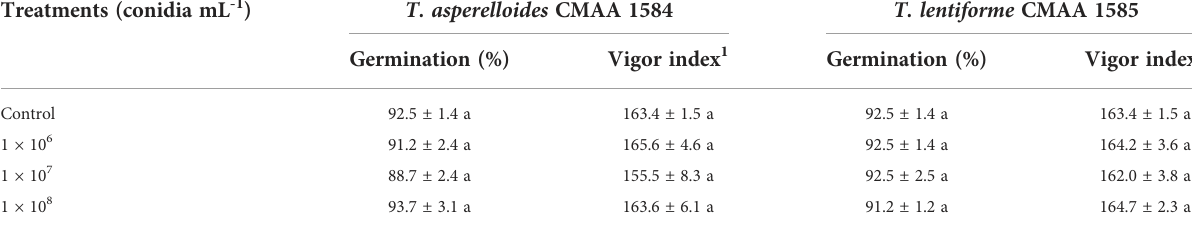
TABLE 3 Effect of Trichoderma asperelloides CMAA 1584 and Trichoderma lentiforme CMAA 1585 in cotton seeds germination and vigor index. Treatments (conidia mL -1